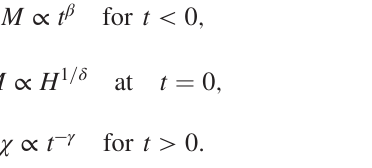
FIG. 3. M 1 = β vs ð H=M Þ 1 = γ isotherms for Sc 3 and (c) non-MF exponents β ¼ 0 . 26 and γ ¼ 1 . 03 , T straight line representing the fit for the critical isotherm. (d) Arrott-Noakes scaling plots M j t j − β vs H j t j − δβ . The scaled M ð H Þ data collapse onto two diverging branches, one below T